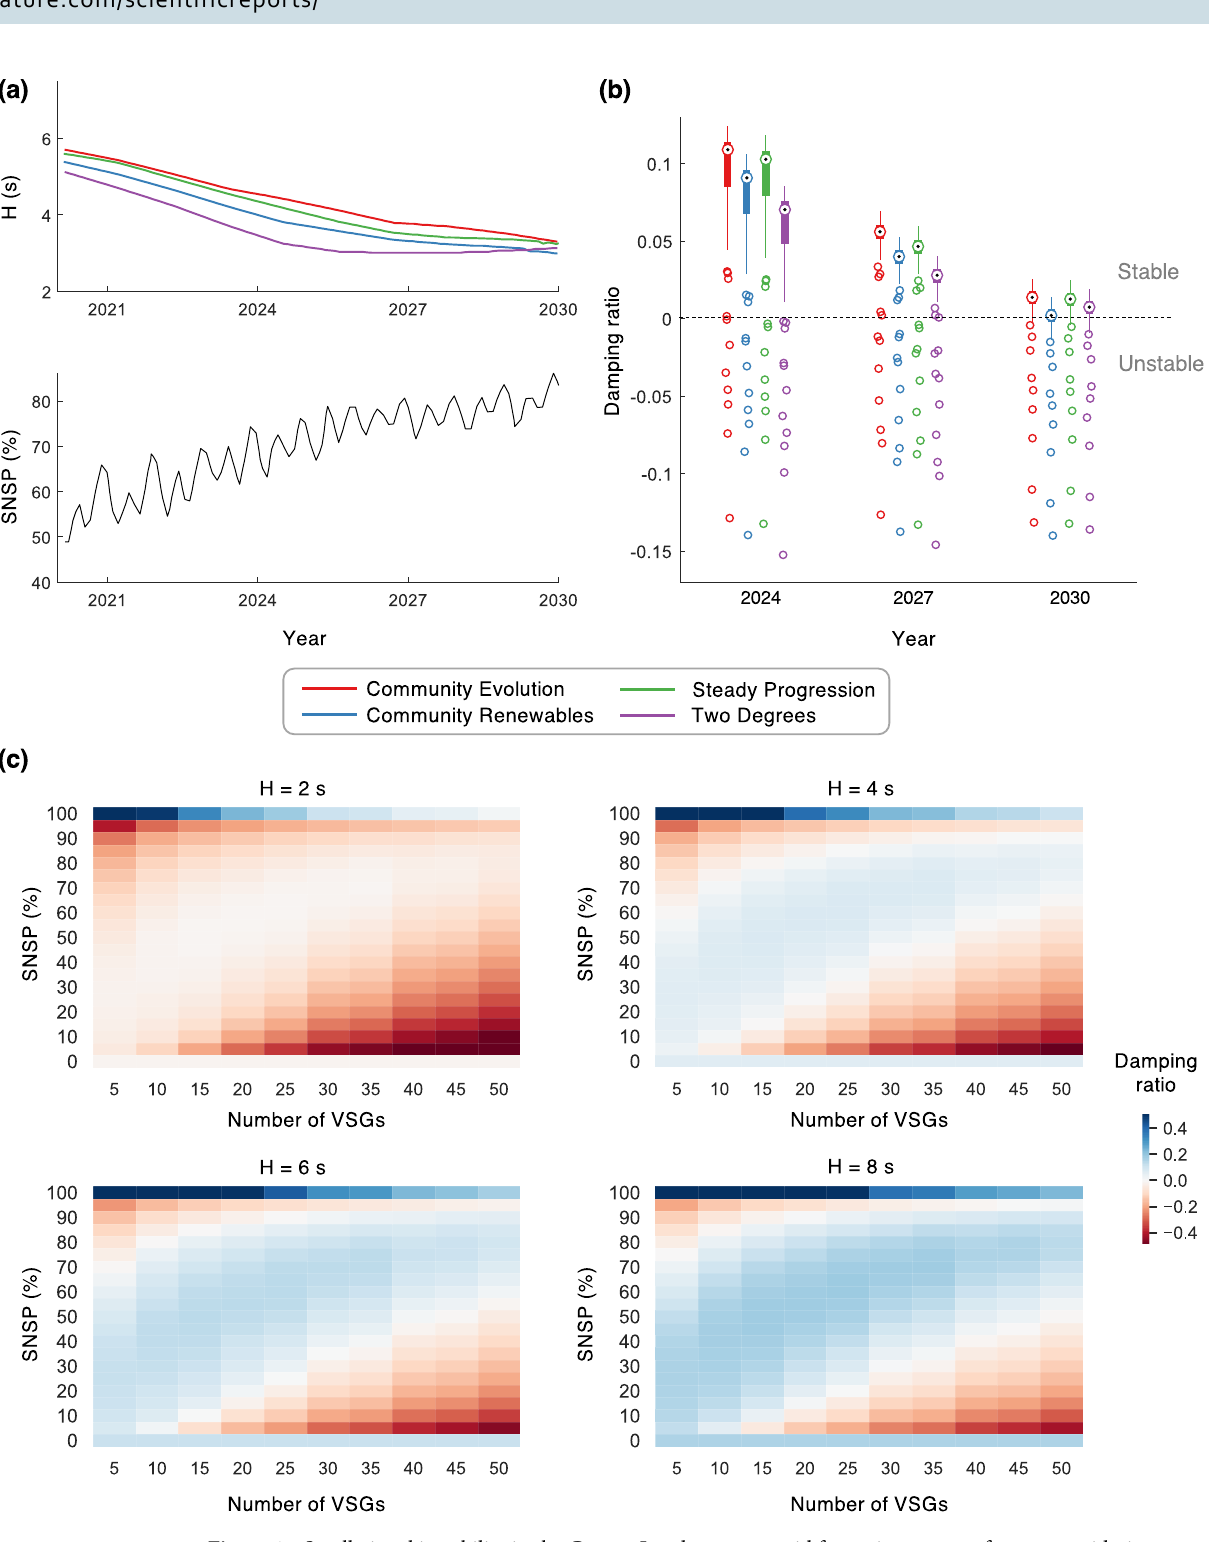
Figure 1. Small-signal instability in the Greater London power grid for various energy futures considering virtual synchronous generators. ( a ) Projections of the mean system inertia constant, H , for four future energy scenarios and the system non-synchronous penetration (SNSP) (Source: National Grid 39,40 ). ( b ) Distributions of the damping ratio for the projected grid in 2024, 2027, and 2030. We assume 30 VSGs provide energy and inertia in addition to the currently-existing rotating synchronous generators. Results are shown for 100 simulations where the locations of the inverters were chosen randomly. The central mark, bottom, and top edges of each box plot represent the median, 25th, and 75th percentiles, respectively. Outliers are marked as individual circles. ( c ) Impact on the grid stability as the number of VSGs and SNSP change. Each cell in the heat maps is the average damping ratio over 100 simulations where the locations of the inverters were chosen